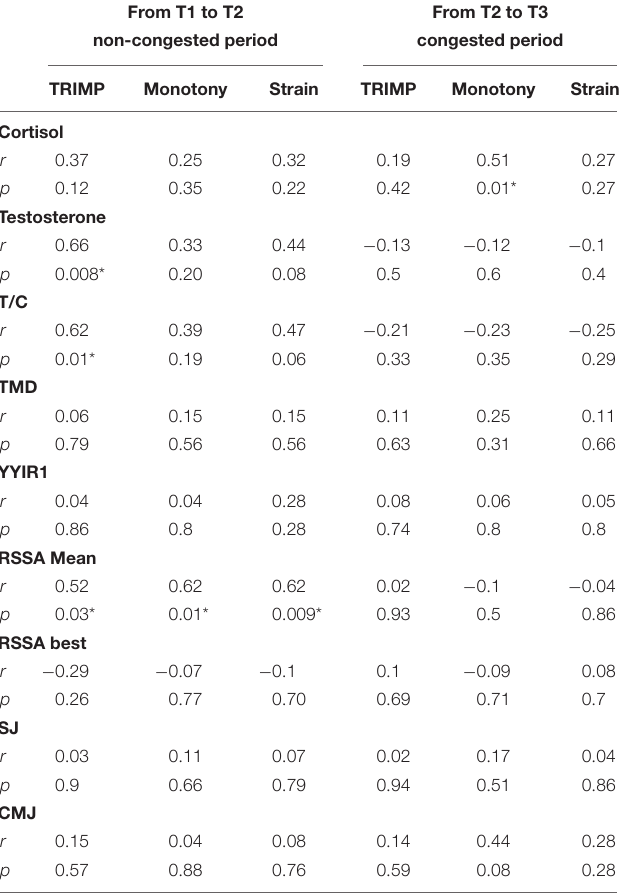
TABLE 10 | Relations between percentage change of hormonal parameters, psychological parameters, and physical fitness and workload parameters. From T1 to T2 From T2 to T3 non-congested period congested period Strain TRIMP Monotony